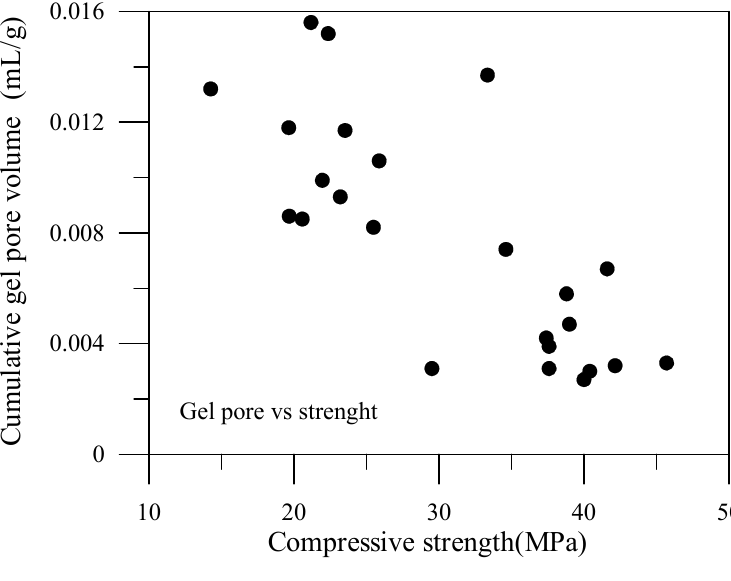
Figure 22. Compressive strength vs. gel pore of specimens with mineral admixtures.